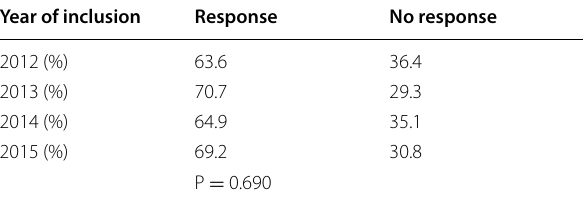
Table 4 Response vs year of